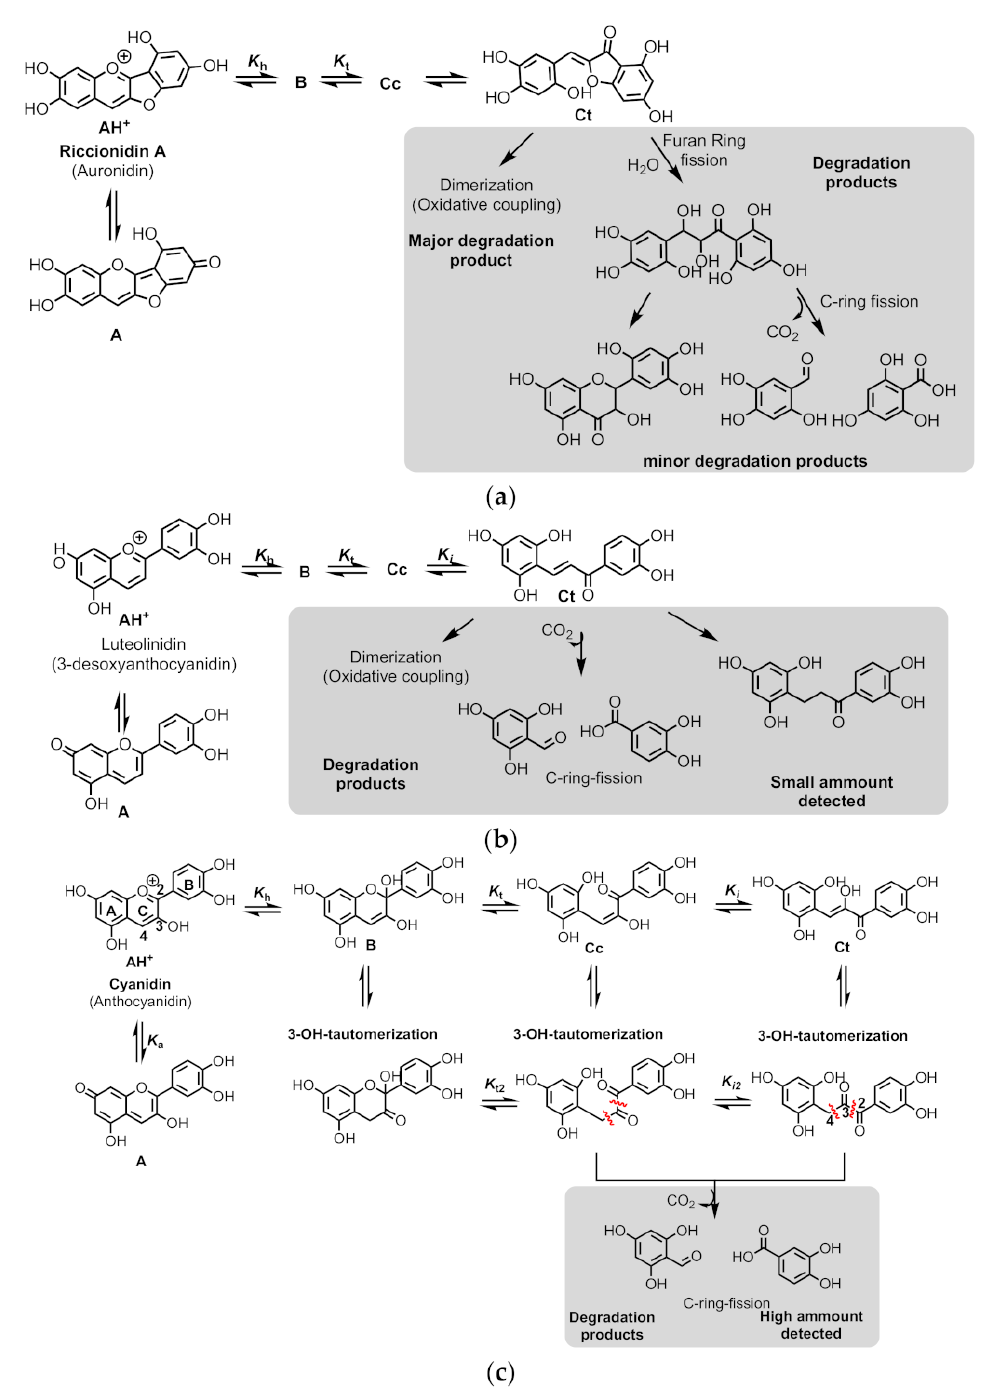
The degradation process of anthocyanidins starts with the keto-enol equilibrium involving C3-OH in hemiketal and chalcones species. The formation of the α -diketone species from the chalcones allows the easily oxidative C-ring fission of the molecule by the cleavage of the C2-C3 or C3-C4 bonds yielding two different degradation products (Scheme 11c) [39,45]. Glycosylation of C3-OH (anthocyanins) prevents this keto-enolic equilibrium and enhances the stability of the molecule. For anthocyanins, the degradation process starts with the breaking of the glycosyl bond releasing the OH group at C3 [45].